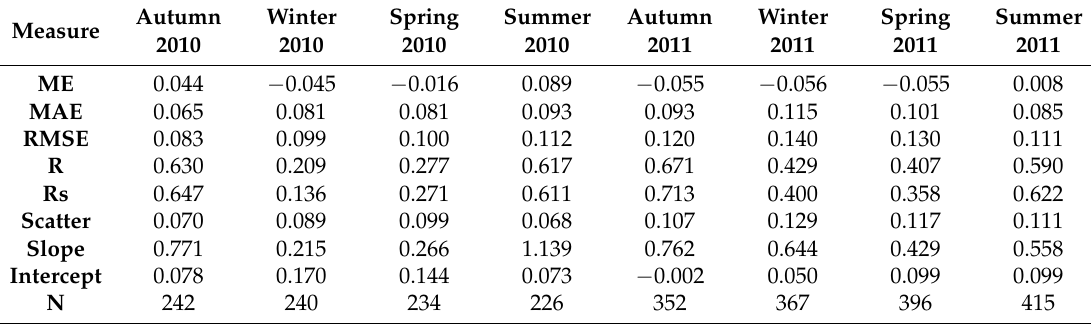
Table 3. Comparison per season between Satellite (ASCAT 25Km) and observed SSM at all validation sites in EUROPE for 2010 and 2011.